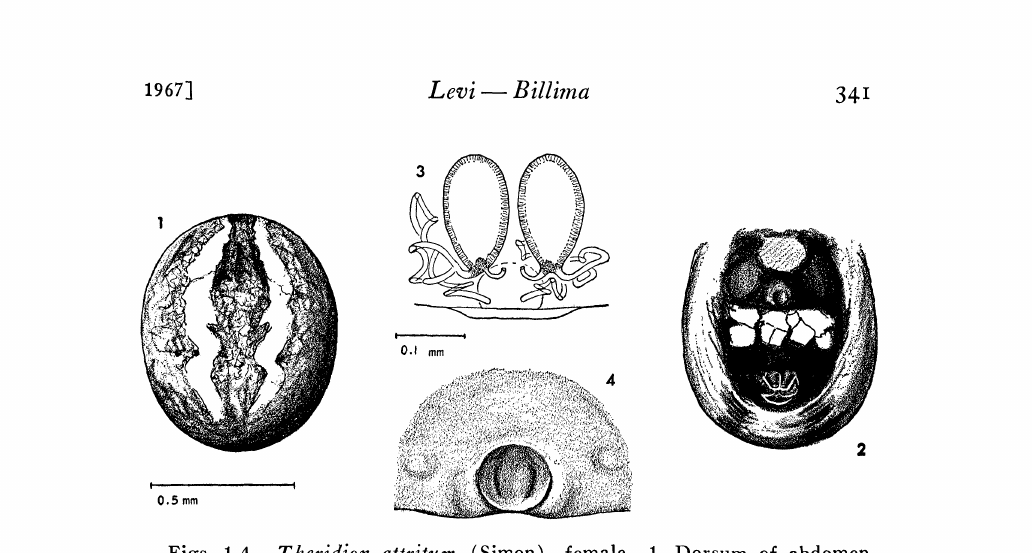
Figs. 1-4. Theridion attritum (Simon), female. 1. Dorsum of abdomen. 2. Venter of abdomen. 3. Female genitalia, dorsal view. 4. Epigynum. Posterior eyes their diameter apart. Labium attached to sternum with indistinct seam. One. tooth on anterior border of